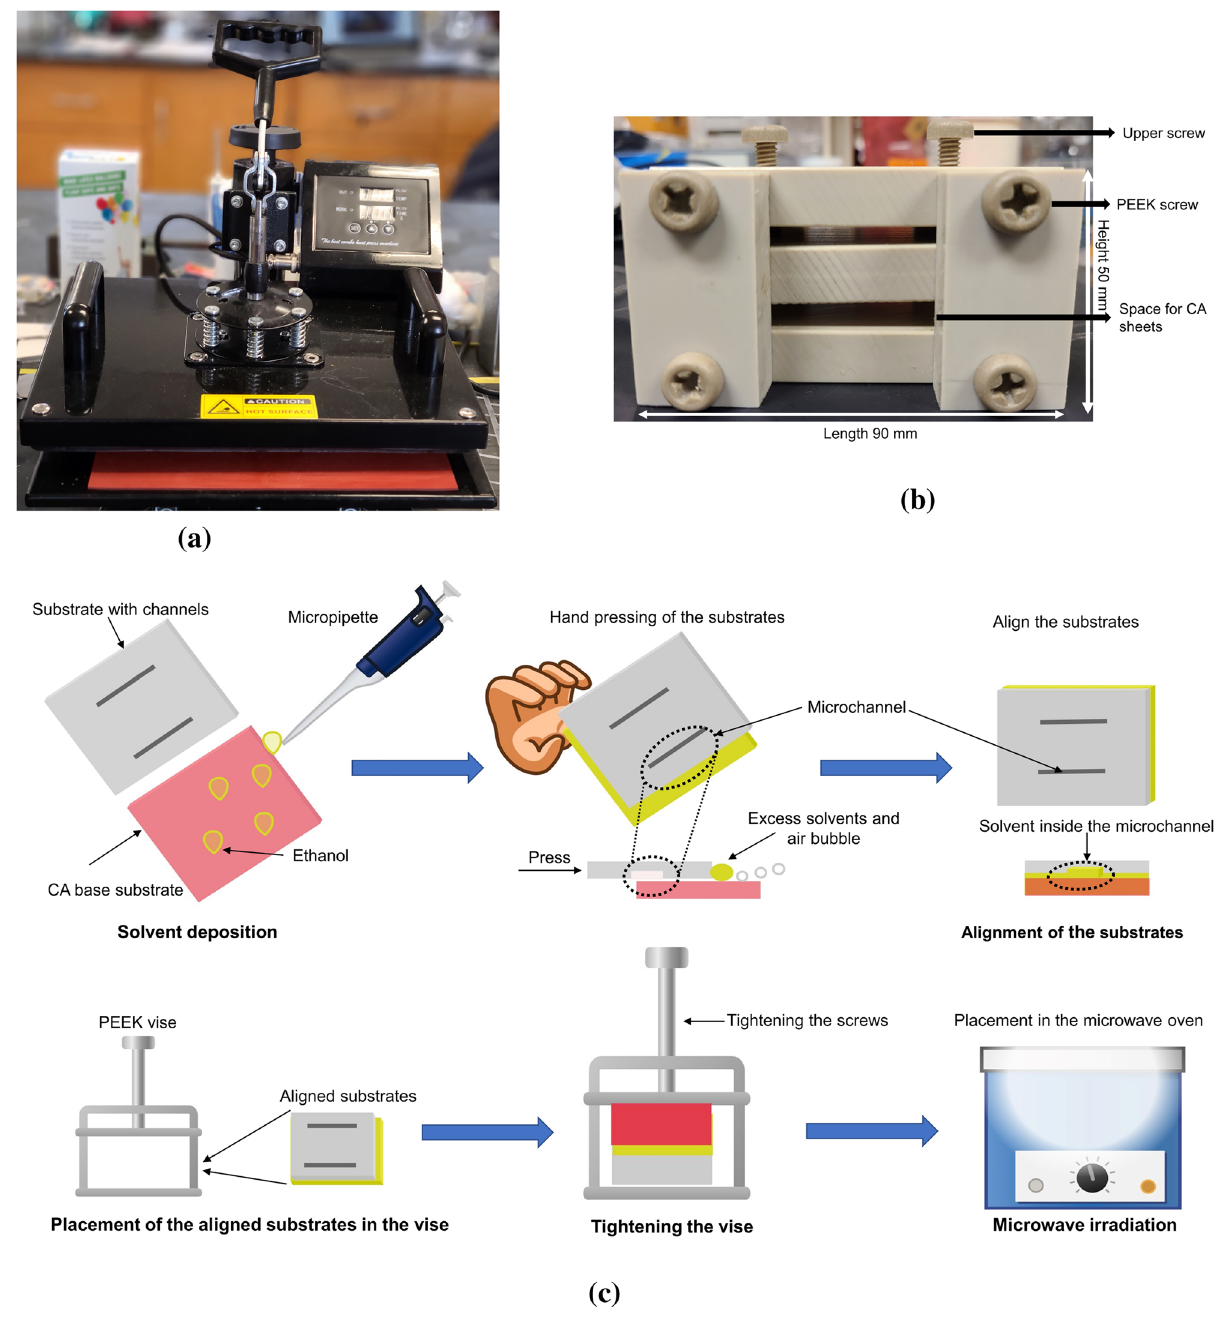
Figure 1. ( a ) Heat press used for thermally assisted bonding. ( b ) Photograph and specifications of laboratory cast PEEK vise used for microwave bonding. ( c ) Schematic illustration of the overall procedure performed for CA bonding with the